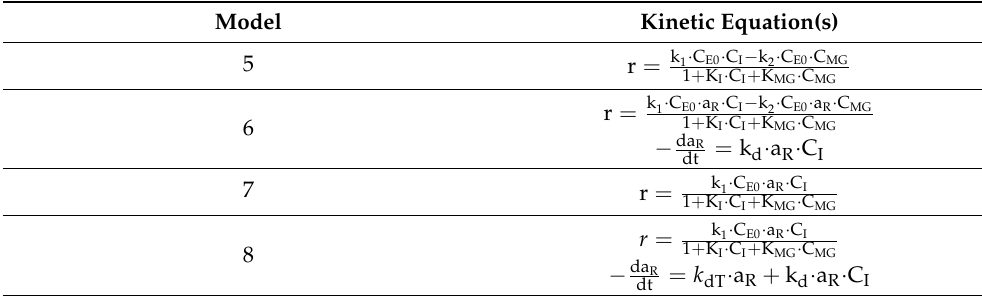
Model 5: Pseudo-first-order reversible hyperbolic model with respect to ibuprofen concentration and monoester concentration without lipase deactivation due to the effect of ibuprofen concentration and